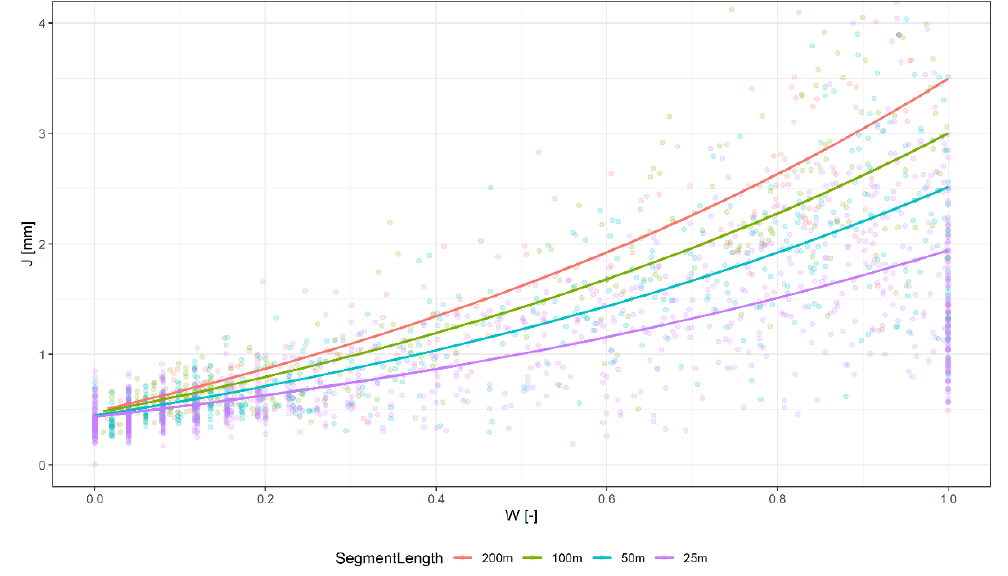
Figure 10. Relationship between the W and J indices values.